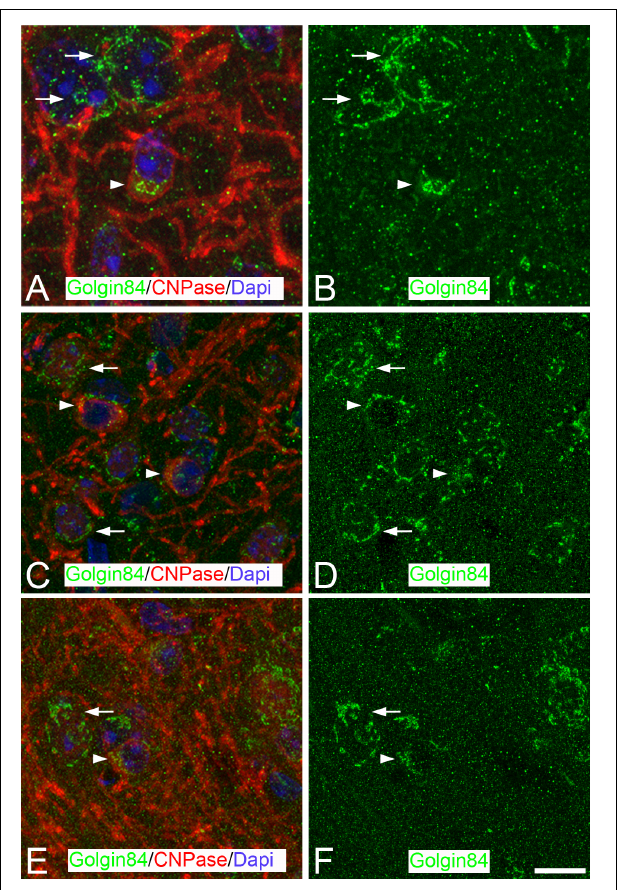
FIGURE 4 | Distribution of GA proteins in neocortical oligodendrocytes throughout the hibernation cycle of the hamster. (A–F) Pairs of mages taken from sections of the neocortex double-immunostained for Golgin 84/CNPase showing the distribution of Golgin84 [green in panels (B,D,F) ] in the GA of oligodendrocytes (identified by CNPase immunostaining) from euthermic hamsters and hamsters at torpor and arousal, respectively. Note the apparent disorganization of the GA elements of oligodendrocytes during torpor and the recovery in arousal. Scale bar shown in panel (F) indicates 6.8 µ m in all